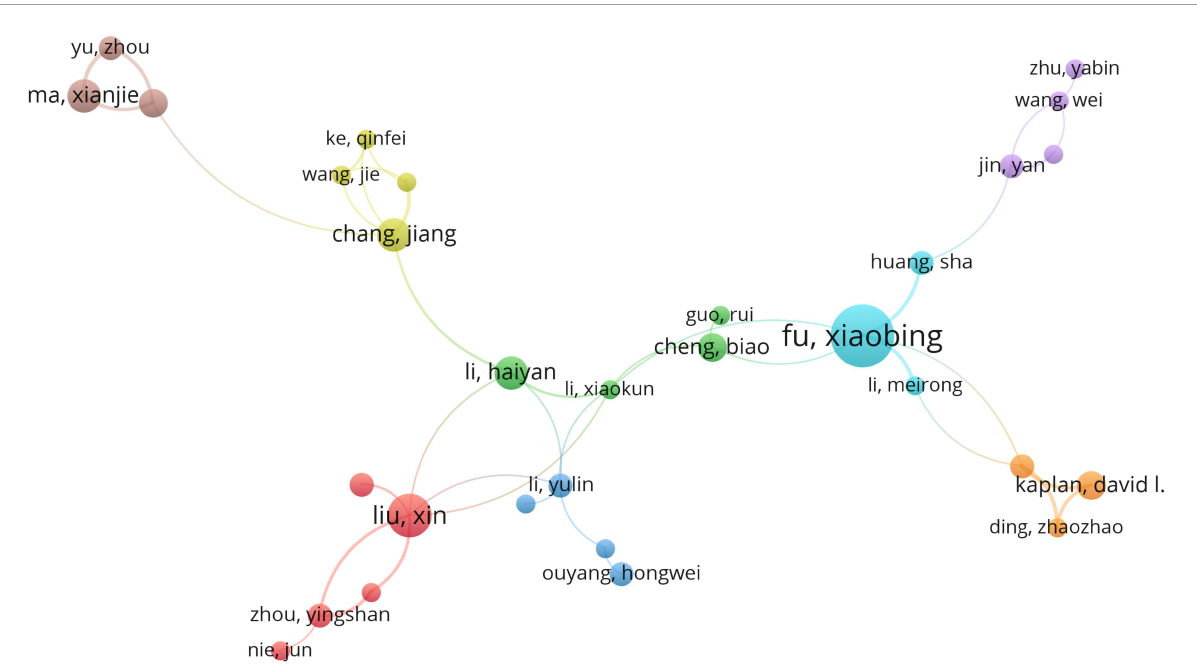
FIGURE5 Co-authorship analysis of authors. The authors were divided into eight clusters, indicated with different colors. The large icon indicates authors with high frequencies. Maximum number of authors per paper: 25; minimum number authors per paper: 4; and minimum number of citations of one author: